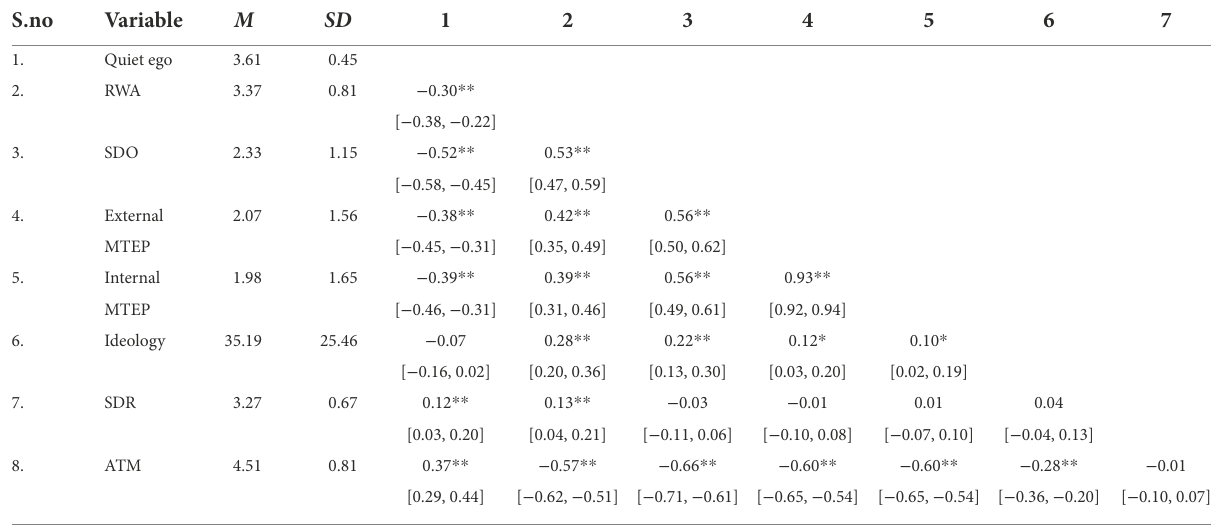
TABLE 3 Means, SDs, and correlations with CIs for Study